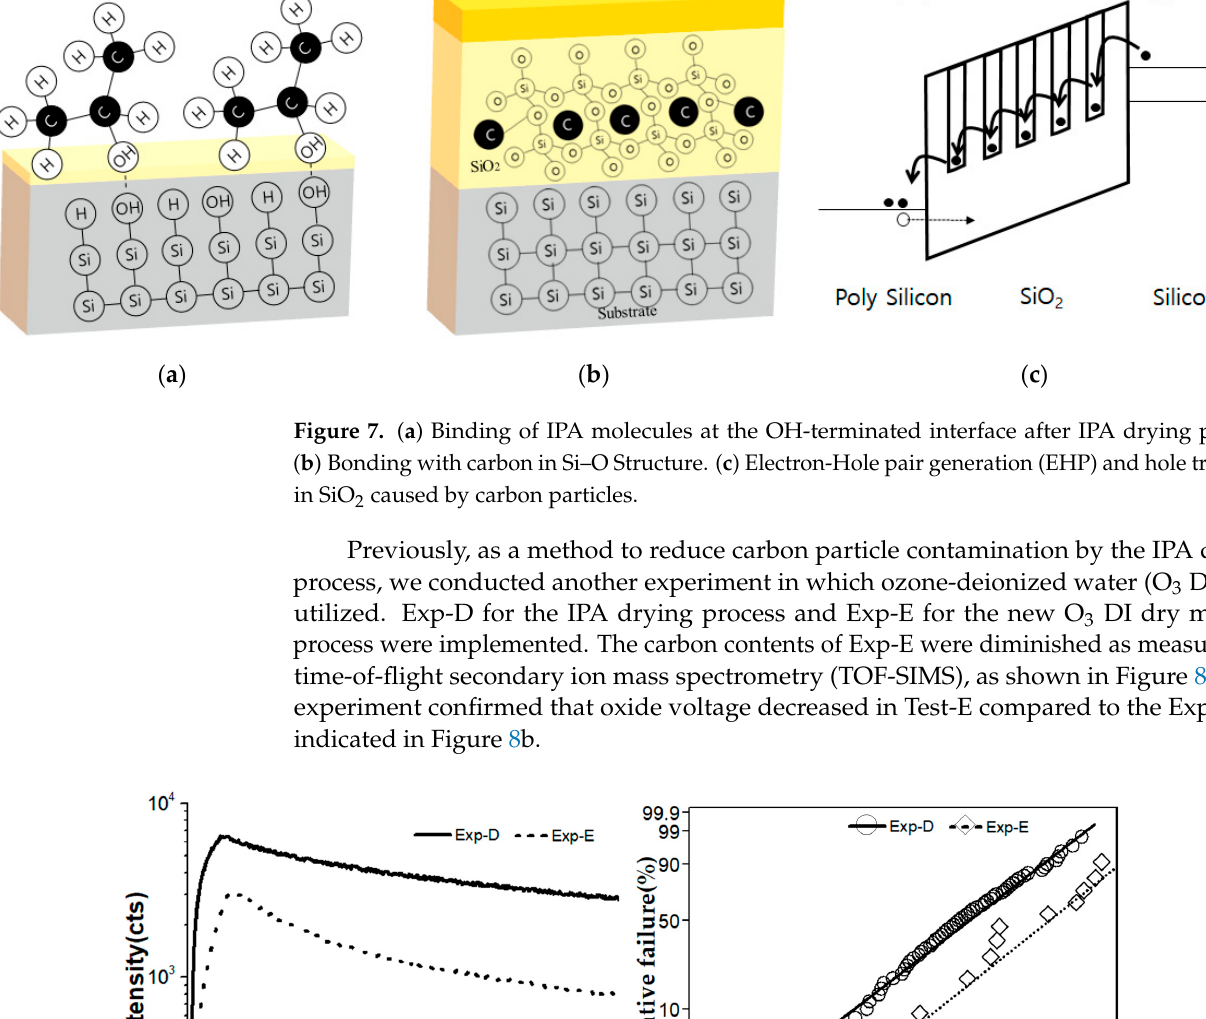
Figure 9. TDDB failure. 4. Conclusions In this study, the pre-cleaning process factors and generation mechanisms that cause gate oxide reliability failure were identified, and methods to overcome them were inves- tigated. After HF cleaning, it was confirmed that the concentration of IPA, which forms a direct trap site inside gate oxide, affects the decrease in G ox reliability. As the concentration of IPA increases, the concentration of carbon at the Si interface increases; then in the gate oxide, carbon-based defect components form a percolation path resulting in a breakdown. To overcome this problem, a new pre-cleaning process was proposed using O 3 -DI water that replaced IPA to fundamentally solve the problem of organic contamination caused by IPA, which is the main cause of the decrease in G ox reliability. Author Contributions: Conceptualization, I.-K.L. and B.-D.C.; methodology, I.-K.L.; software, I.- K.L.; validation I.-K.L.; formal analysis I.-K.L.; resources I.-K.L.; data curation I.-K.L.; writing I.-K.L. All authors have read and agreed to the published version of the manuscript. Funding: This research was supported by the SungKyunKwan University and the BK21 FOUR (Graduate School Innovation) funded by the Ministry of Education (MOE, Korea) and National Re- search Foundation of Korea (NRF) And this work was funded and conducted under the Compe- tency Development Program for Industry Specialists of the Korean Ministry of Trade, Industry and Energy (MOTIE), operated by Korea Institute for Advancement of Technology (KIAT). (No. P0012453, Next-generation Display Expert Training Project for Innovation Process and Equipment, Materials Engineers).